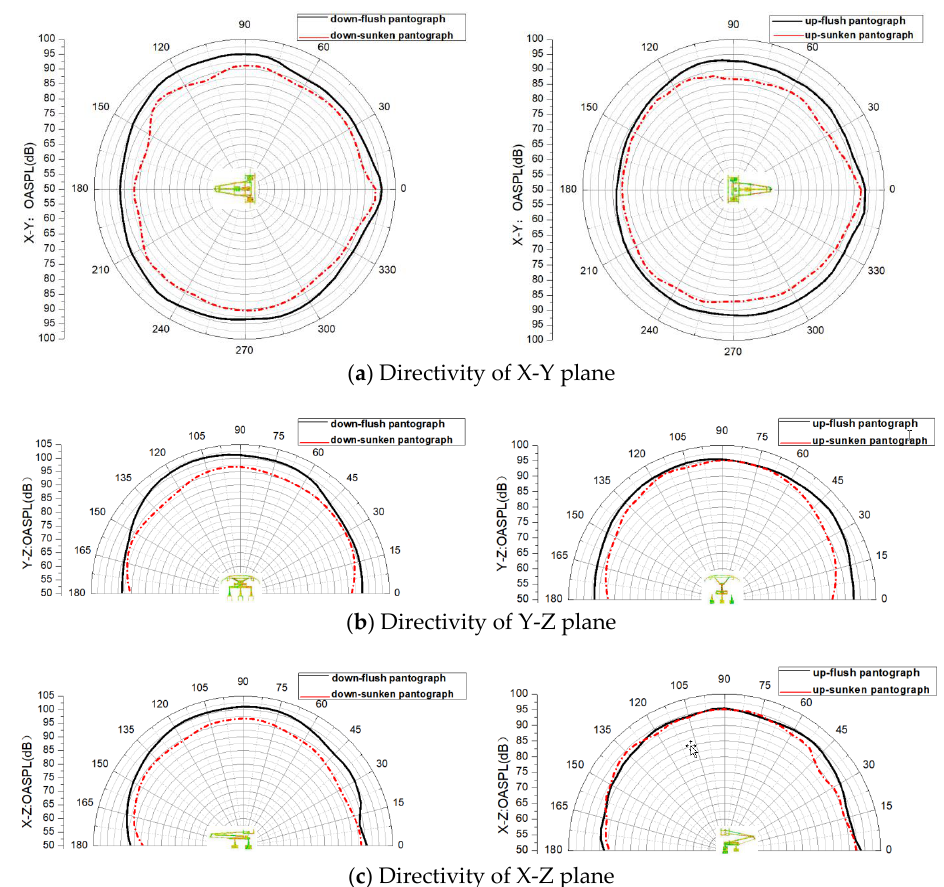
Figure 19. Noise directivity induced by pantograph in different planes (the left side figures show the down condition and the right side figures show the up condition): ( a ) directivity of X-Y plane; ( b ) directivity of Y-Z plane; and ( c ) directivity of X-Z plane. ( b ) directivity of Y-Z plane; and ( c ) directivity of X-Z